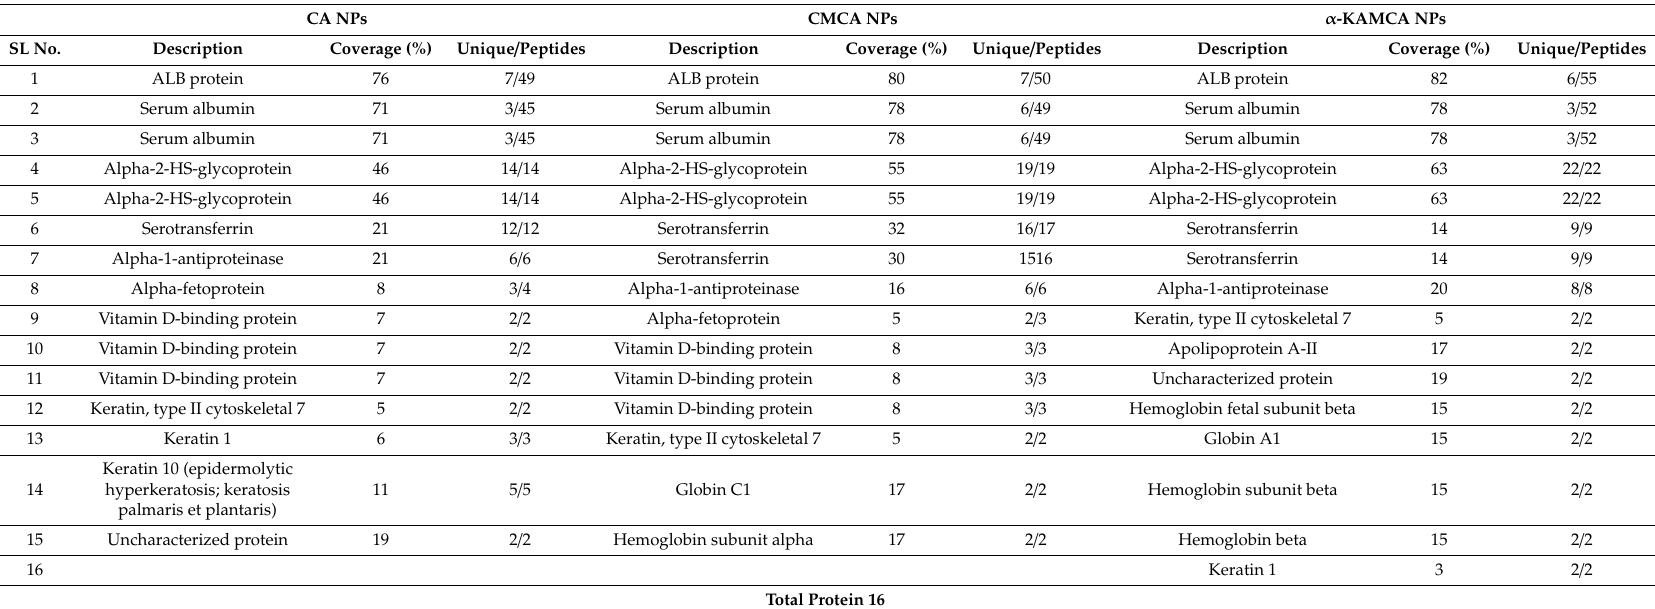
Table 6. Protein distribution around CA, CMCA, and α -KAMCA NPs in 10% fetal bovine serum